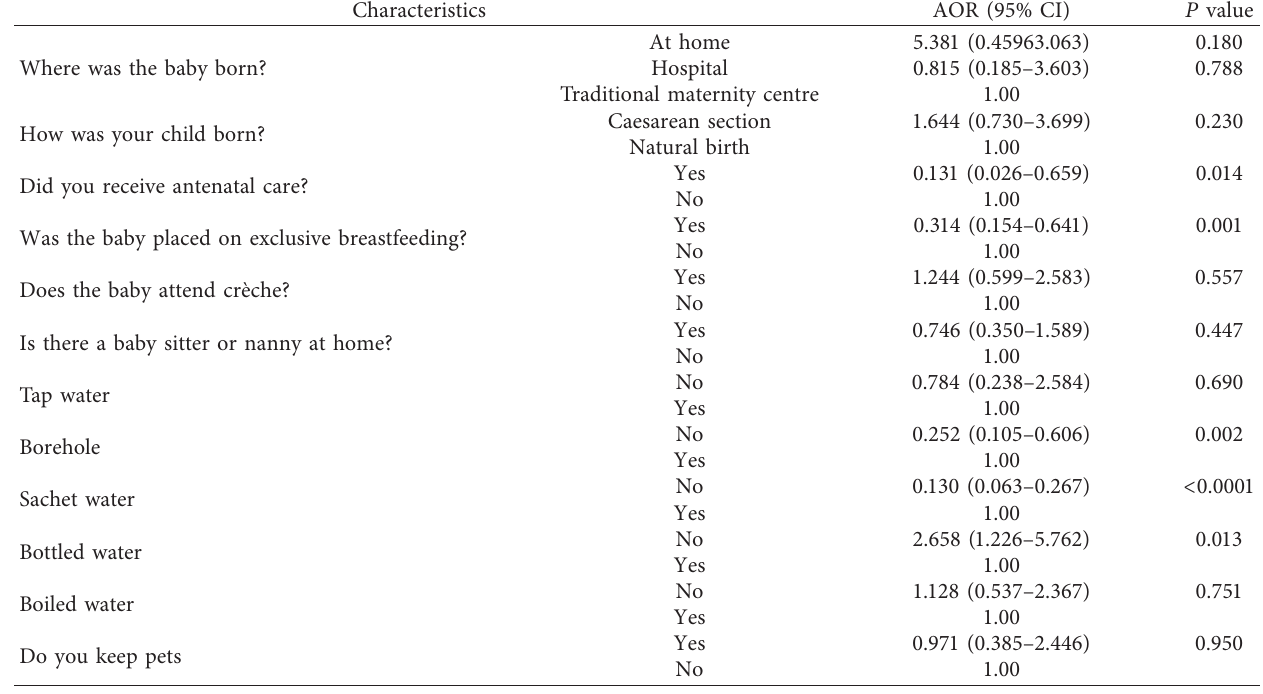
Table 5: Multivariate Analysis of medical history and the environment as risk factors or diarrhoea in the study.